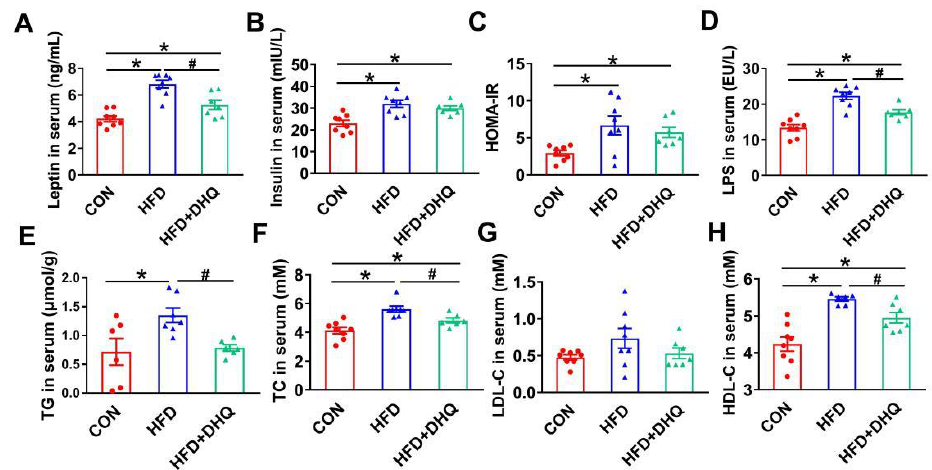
Figure 2. Effects of DHQ on serum parameters in mice. ( A ) Leptin; ( B ) insulin; ( C ) HOMA ‐ IR; ( D ) LPS; ( E ) TG; ( F ) TC; ( G ) LDL ‐ C; and ( H ) HDL ‐ C. Data were expressed as the mean ± SEM. * p < 0.05 vs. CON group, # p < 0.05 vs. HFD group.